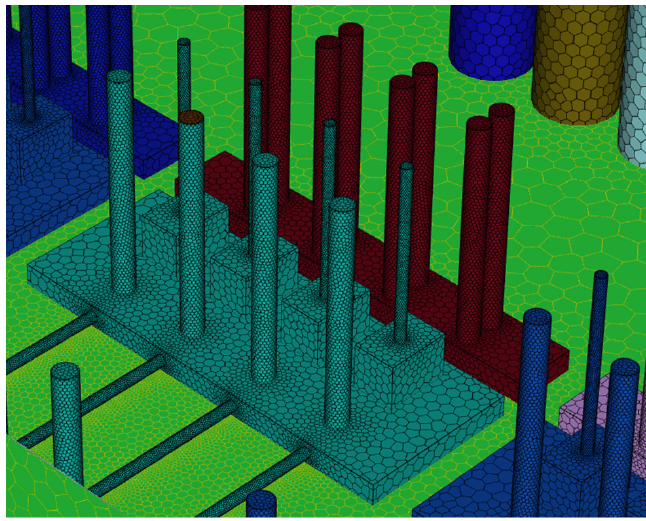
Figure 3. Polyhedral mesh creation.